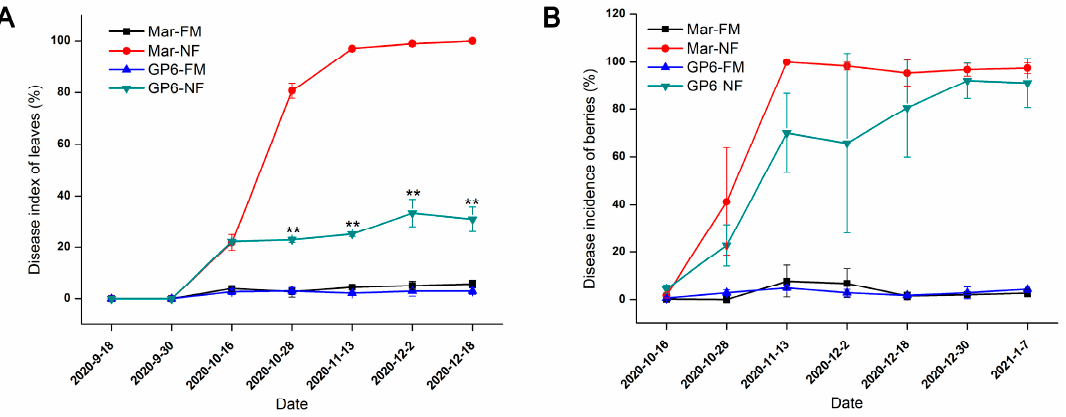
Figure 1. ( A ) Disease index of grape leaves regarding infection with powdery mildew. ( B ) Disease incidence of berries regarding infection with powdery mildew. Data represent mean values, and the bars show standard deviations ( n = 3). Double asterisks located above a set of symbols indicate a significant difference of p < 0.01 compared between Mar-NF and GP6-NF.